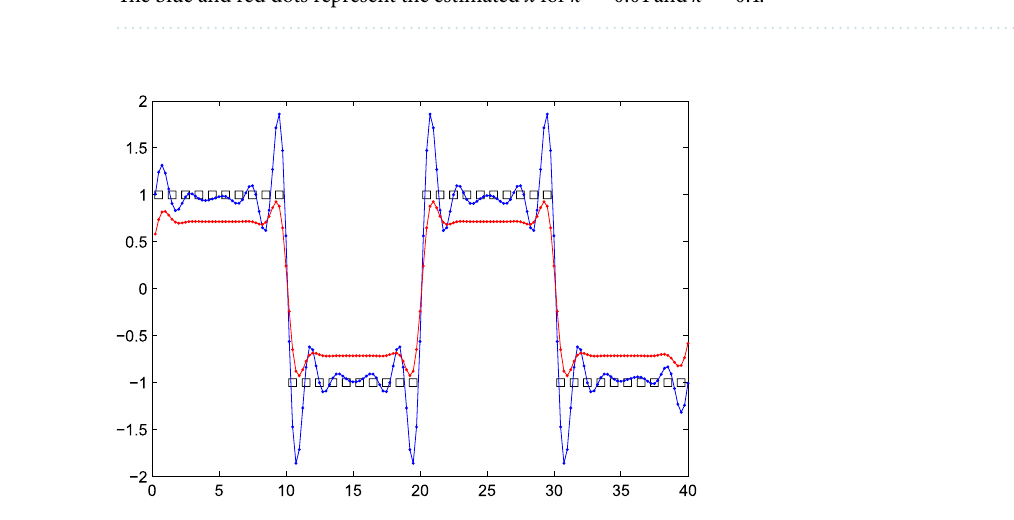
Figure 2. Fourfold super-resolution of a simulated step wave, demonstrating overshoot (ringing). The squares show the “observed” series. The blue and red dots represent the estimated ˆ x for κ = 0.01 and κ = 0.1 . They have been connected by lines for